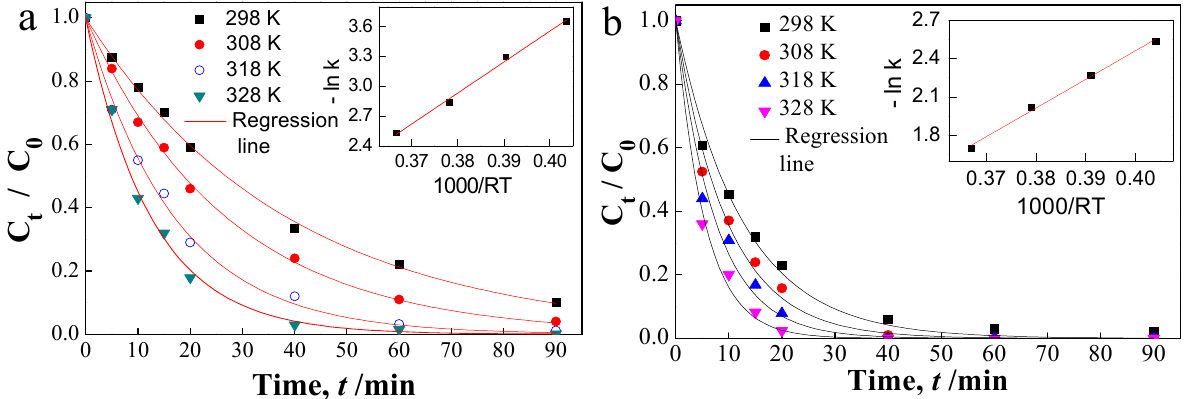
Figure 4. Effect of temperature on reaction process of ( a ) Fe CP and ( b ) FeSiB AR in the Pb(II) solution. Insert: Arrhenius plots of − ln k versus 1000/ RT for the two kinds of materials, respectively. In order to investigate the removal mechanism of the amorphous ribbon, XRD patterns of the reacted FeSiB AR are compared with the reacted Fe CP . Figure 5 shows XRD patterns of the FeSiB AR and Fe CP after reaction with the aqueous solution for 40 min at room temperature. Diffraction peaks of FeO(OH) appear on both the XRD patterns of the reacted FeSiB AR and Fe CP . According to the studies of treatment on Pb(II)-contaminated solution by ZVI, the FeO(OH) complexes with strong flocculation coprecipitate with Pb(II) during the reaction process (Equation (2)) [19]. Therefore, a small part of Pb(II) in aqueous solution was also removed by FeSiB AR by absorption and coprecipitating with Pb(II). Furthermore, compared with Fe CP , a large number of diffraction peaks of Pb are found on XRD patterns of the reacted FeSiB AR and the precipitate of FeSiB AR , indicating that reduction (Equation (3)) played an important role in the removal process of Pb(II) by FeSiB AR . In addition, there are some tiny unknown diffraction peaks found on the XRD patterns of the reacted FeSiB AR and the precipitate. Combined with XRD patterns of the reacted FeSiB AP and FeSiB BP , which will be discussed later, these tiny diffraction peaks may represent SiO 2 and PbO.